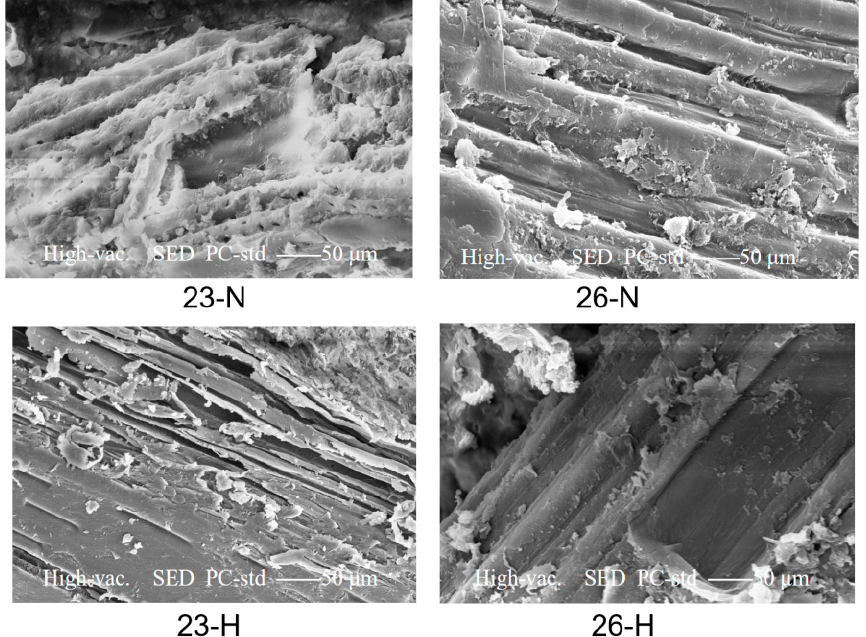
Figure 11. SEM image of seedling tray. Note: 23-N and 26-N show the regularly compressed seedling trays made of material with a moisture content of 23% and 26%; 23-H and 26-H show the hot-compressed seedling trays made of material with a moisture content of 23% and 26%. After molding and drying, the straw gap in the trays with a moisture content of 23% was smaller than that in the tray with a moisture content of 26%. As shown in 23-H and 26-H, most of the gaps between stem fibers in 23-H were filled and adhered by the lignin separated out from the stem fiber, and most of the multilayered stem fibers with a mosaic structure were wrapped by lignin. For the material with a moisture content of 26%, after compression under a high temperature (26-H), the gaps between multilayered stem fibers were also filled and adhered by the lignin. However, not all of them were filled or ad- hered, and the multilayered stem fibers with a mosaic structure wrapped by lignin were fewer. The gaps between the cellulose as shown in the SEM images were caused by the in- ternal stress and moisture of the material. During the compression process, the internal stress still existed due to the uneven volume changes in the microstructure of the material. When the external load disappeared, gaps formed in the molded material. After being separated out from the material, lignin adhered to the fibers nearby to create a new struc- ture, and most of the internal stress was offset by the adhesion stress of lignin after the external load disappeared. Therefore, both the expansion rate and the porosity of the molded hot-compressed seedling tray were smaller than those of the regular compression molding seedling tray. The water in the material also filled the gaps during the compres- sion process but evaporated after drying to produce gaps again. Thus, the greater the amount of water, the larger the gap after drying. Therefore, the stem fiber gaps in 26-N and 26-H were larger than those in 23-N and 23-H. The mechanical setting force of the material is produced due to the stacking and squeezing. Hence, the larger the material gap, the smaller the mechanical setting force. Therefore, in the universal testing machine test, the bending strength of the seedling tray made of material with a moisture content of 23% was greater than that of the seedling tray made of material with a moisture content of 26%. The lignin flow in the material has two stages. In the first stage, after reaching the softening temperature, the lignin in the stem fiber flows and precipitates under internal pressure, filling the gaps between adjacent stem fibers. In this process, the higher the fill- ing rate, the better the integrity of the seedling tray and the adhesion effect of lignin, and